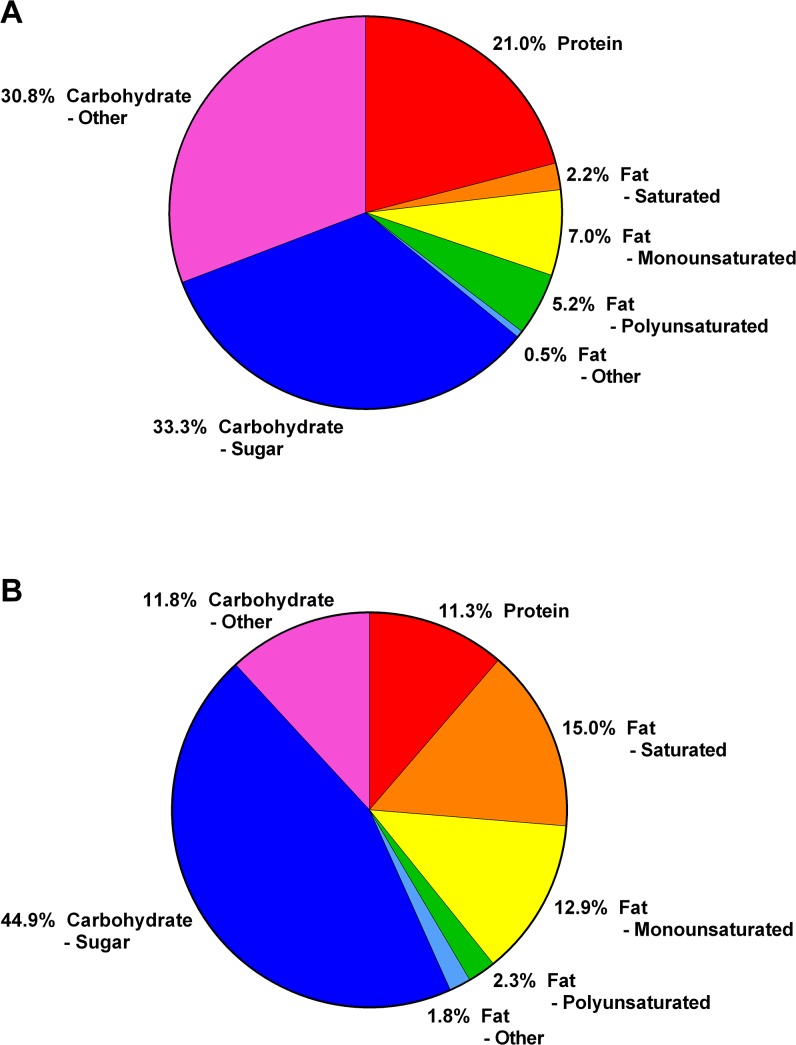
Macronutrient composition of animal diets.(A) Standard rat chow. (B) Obesogenic diet. Values expressed as a percentage of the total calorie content contributed by all macronutrients.